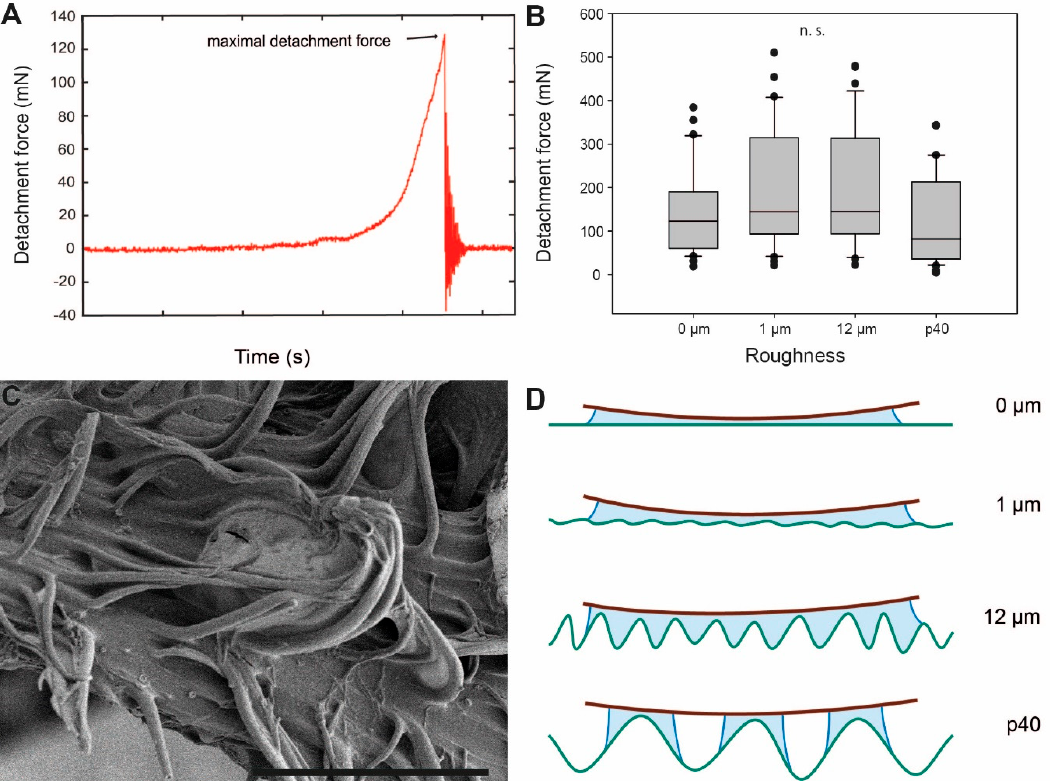
Figure 5. Influence of roughness on egg adhesion. ( A ) . Exemplary force-time curve from measurements of the detachment force. ( B ) Detachment forces from substrates with different surface asperity ( N = 32 for each roughness). Boxes are 25 th and 75 th percentiles, the line within the boxes defines the median, and whiskers represent the 10 th and 90 th percentiles. n. s. = no statistical difference ( p > 0.05, Kruskal–Wallis ANOVA on ranks). ( C ) Scanning electron microscopy image of pinnae deformation showing the adaptation of pinna extensions to surface corrugations. ( D ) Schematic interpretation of the eggs’ glue with differing degrees of surface roughness. Roughness parameters are given in detail by Salerno et al. [74]. Scale bar: 60 µm.